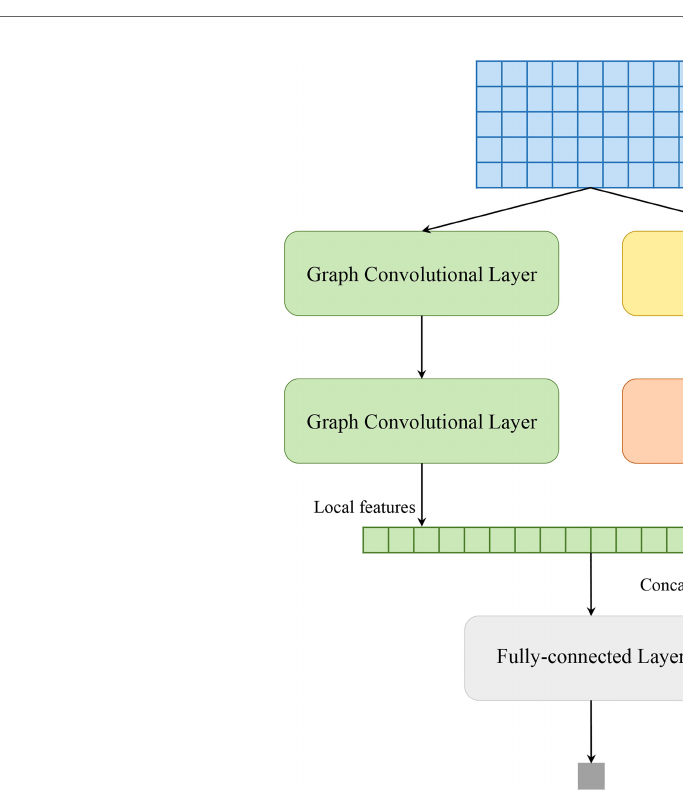
FIGURE 1 | Model architecture of proposed method in this